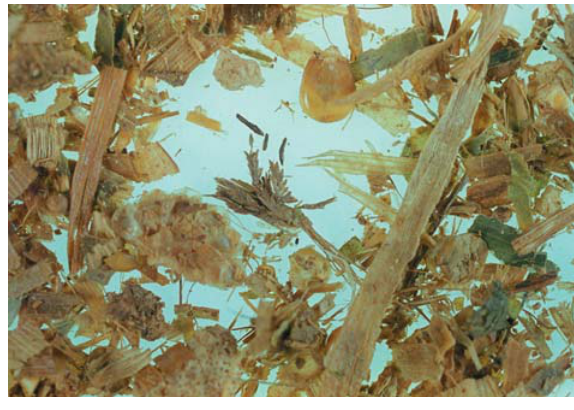
FIG. 5 Change in average milk yield in relation to feeding and withdrawal of incriminated maize silage in the first out- break. The date of the first visit to the farm is indicated by the arrow